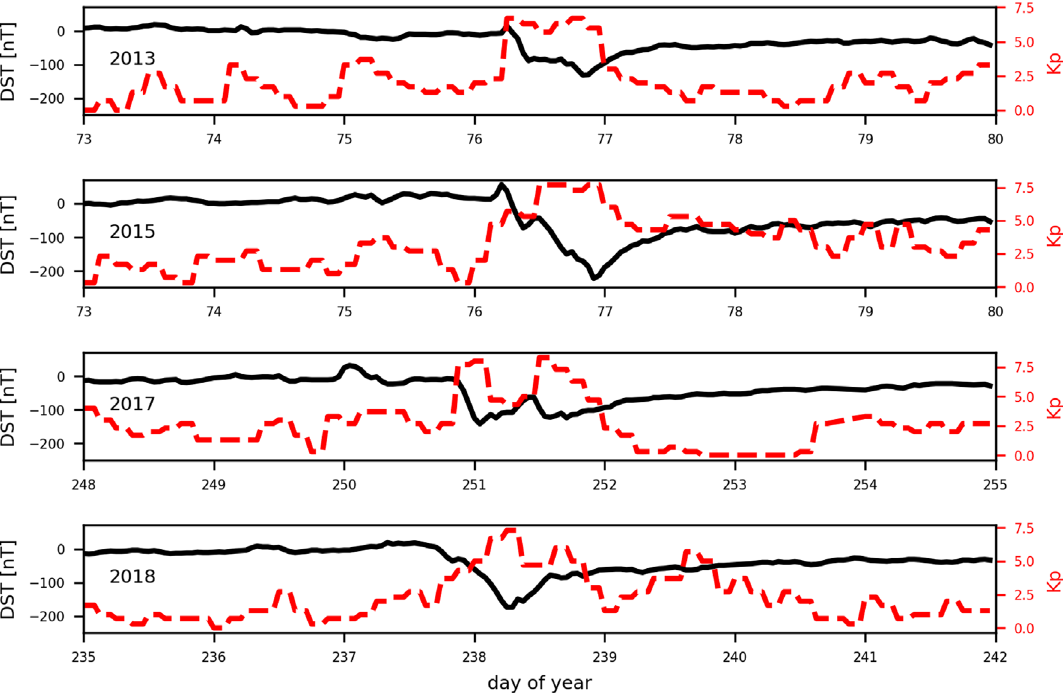
Fig. 1. Dst and Kp values observed in the selected storm events. Indices values were obtained from the OMNI data set provided by the Goddard Space Flight